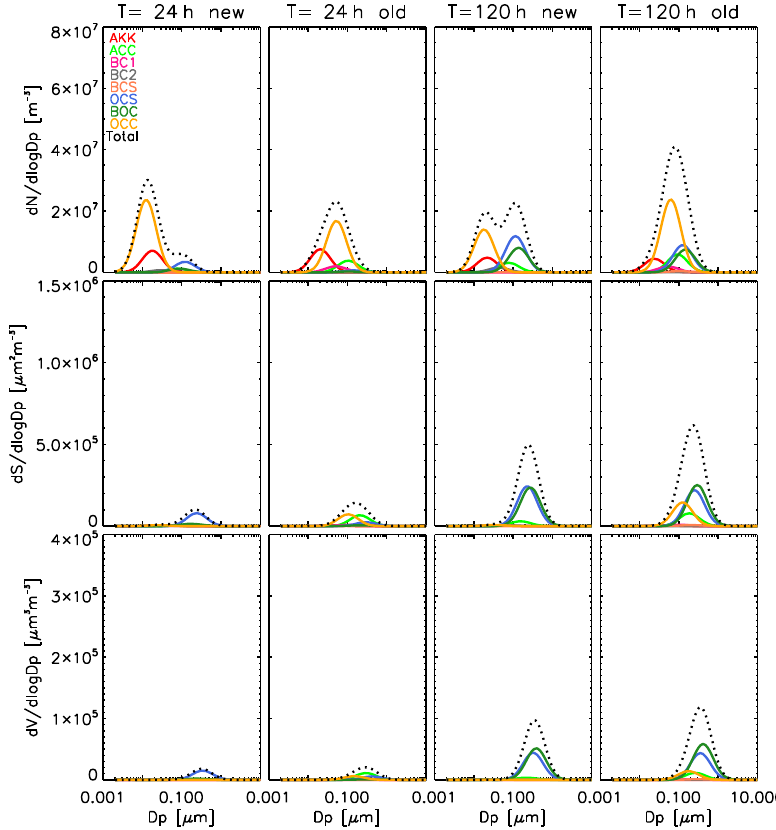
Figure 7. Same as Fig. 6 for